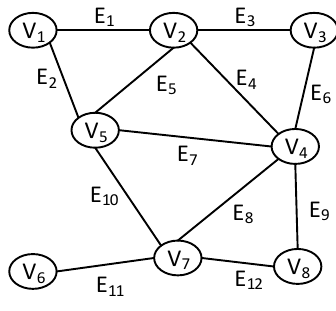
Figure 11. The updated RAG.